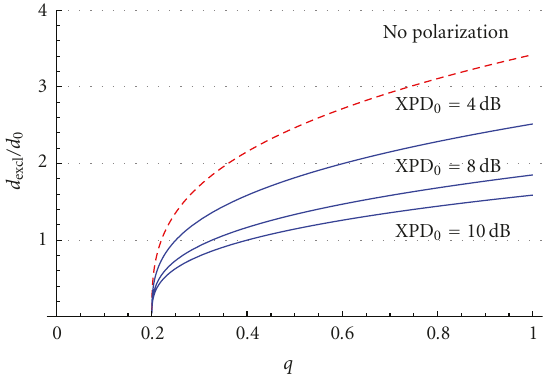
Figure 2: Primary exclusive region as a function of the terminal probability of transmission q , for various polarimetric values and with ε = 0 .